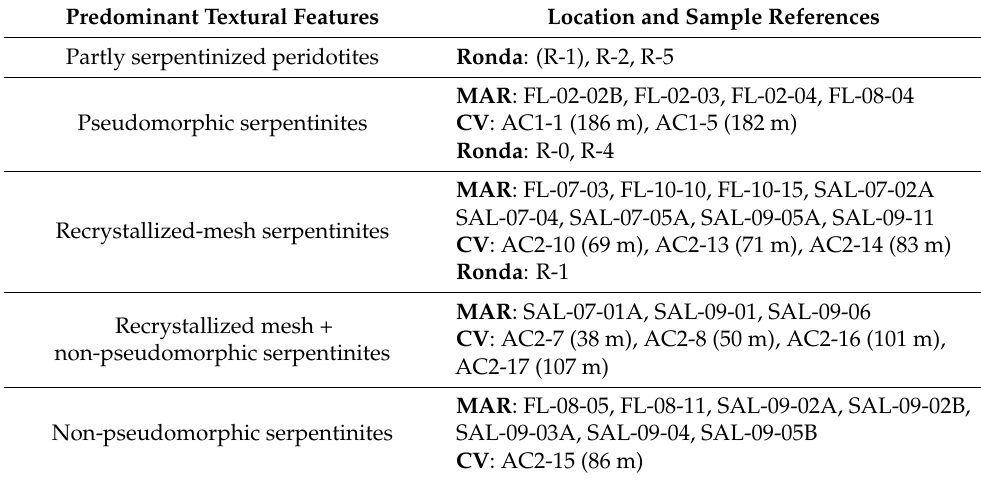
Table 1. Sample distribution according to predominant serpentine textural